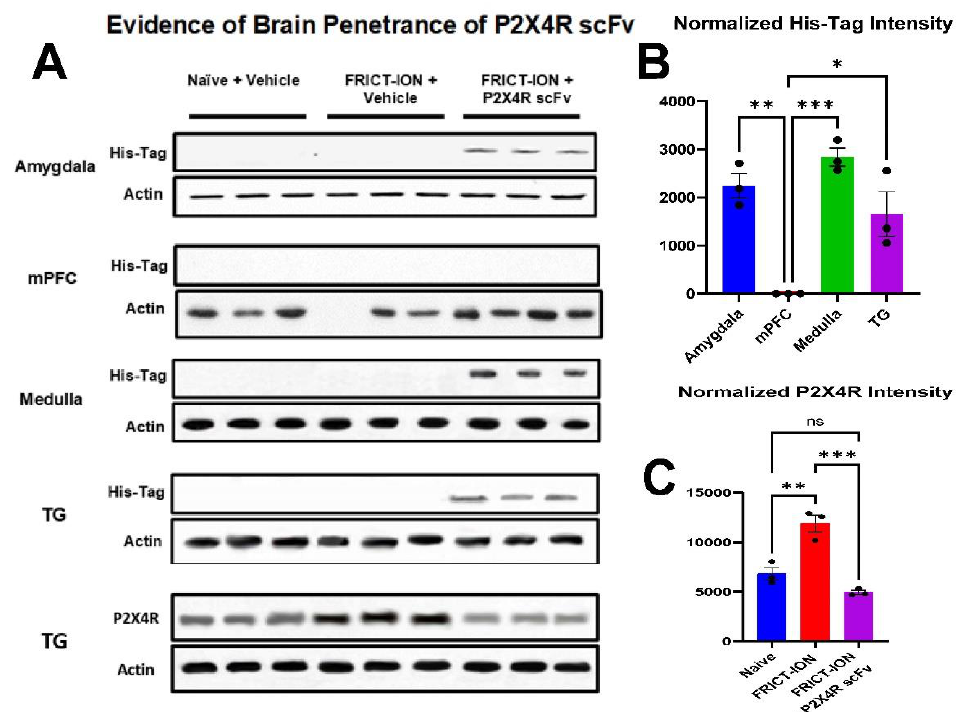
Figure 7. Evidence of P2X4R scFv 95 in brain and trigeminal ganglia, while P2X4R scFv 95 treatment prevents the P2X4R protein elevation in trigeminal ganglia of untreated FRICT-ION mice. ( A ). His-tag biomarker in the brain indicates brain penetrance of the P2X4R scFv 95 in amygdala, medulla, and trigeminal ganglia. ( B ). Bar graph of the scFv His-tag in the amygdala, brainstem medulla dorsal horn, and trigeminal ganglia (TG) in the Western blots. The His-tag remains at 7 weeks after the single i.p. dose was given in male mice with FRICT-ION. Almost no His-tag was detected in the medial prefrontal cortex (mPFC) in these comparisons with normalized intensity in arbitrary units.